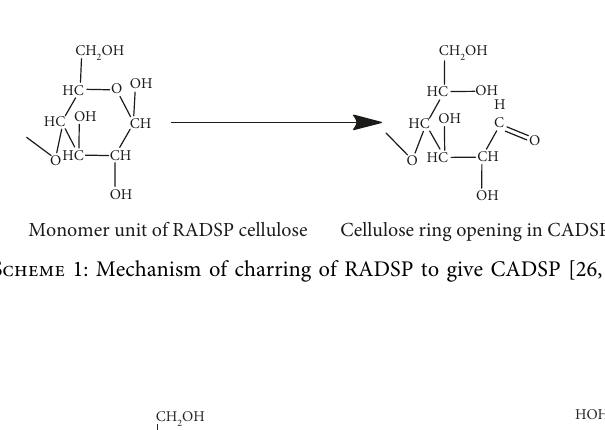
Figure 12: (a) Desorption percentage of Cr(VI) vs. concentration of NaOH, and (b) fluctuation in the adsorption capacity of CADSP during the subsequent cycle of adsorption and desorption.